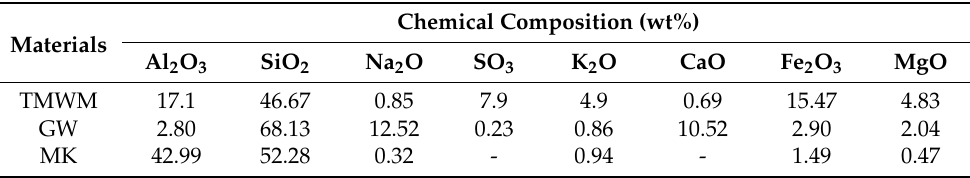
Table 1. Chemical composition of tungsten mining mud waste (TMMW), glass waste (GW), and metakaolin (MK) in wt%.